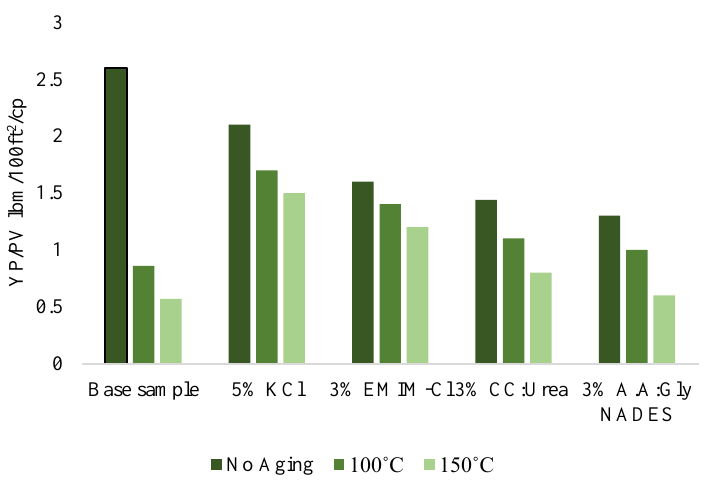
Figure 2. Comparison of YP/PV of NADES-based mud with other inhibitors.